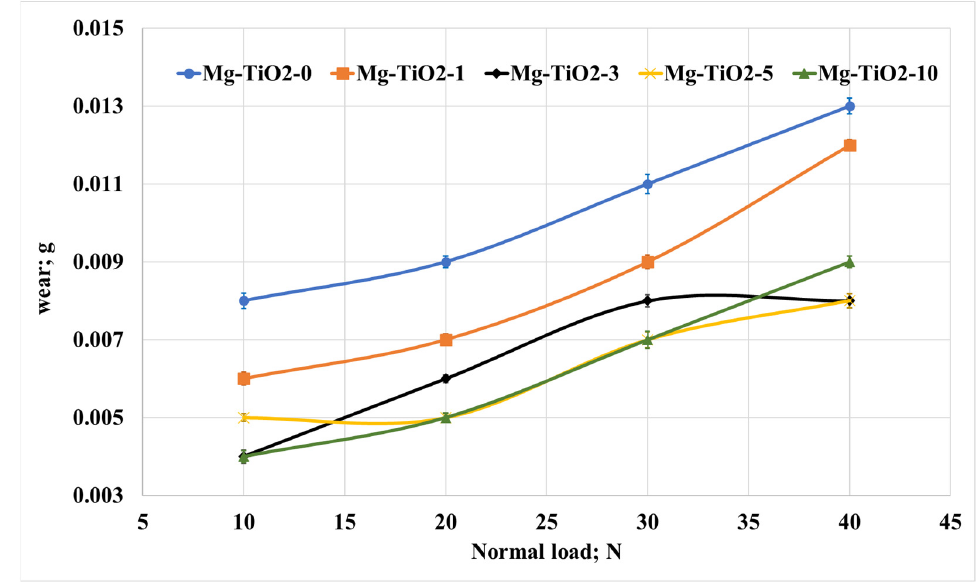
Figure 7. Wear of Mg/TiO 2 nanocomposites under different normal loads, 900 m.